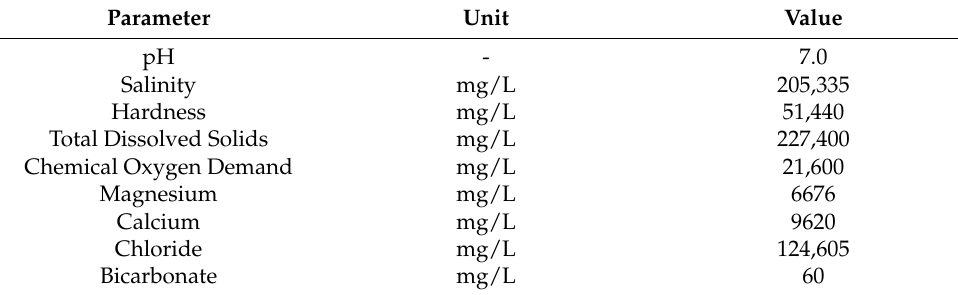
Table 1. Characteristics of produced water.